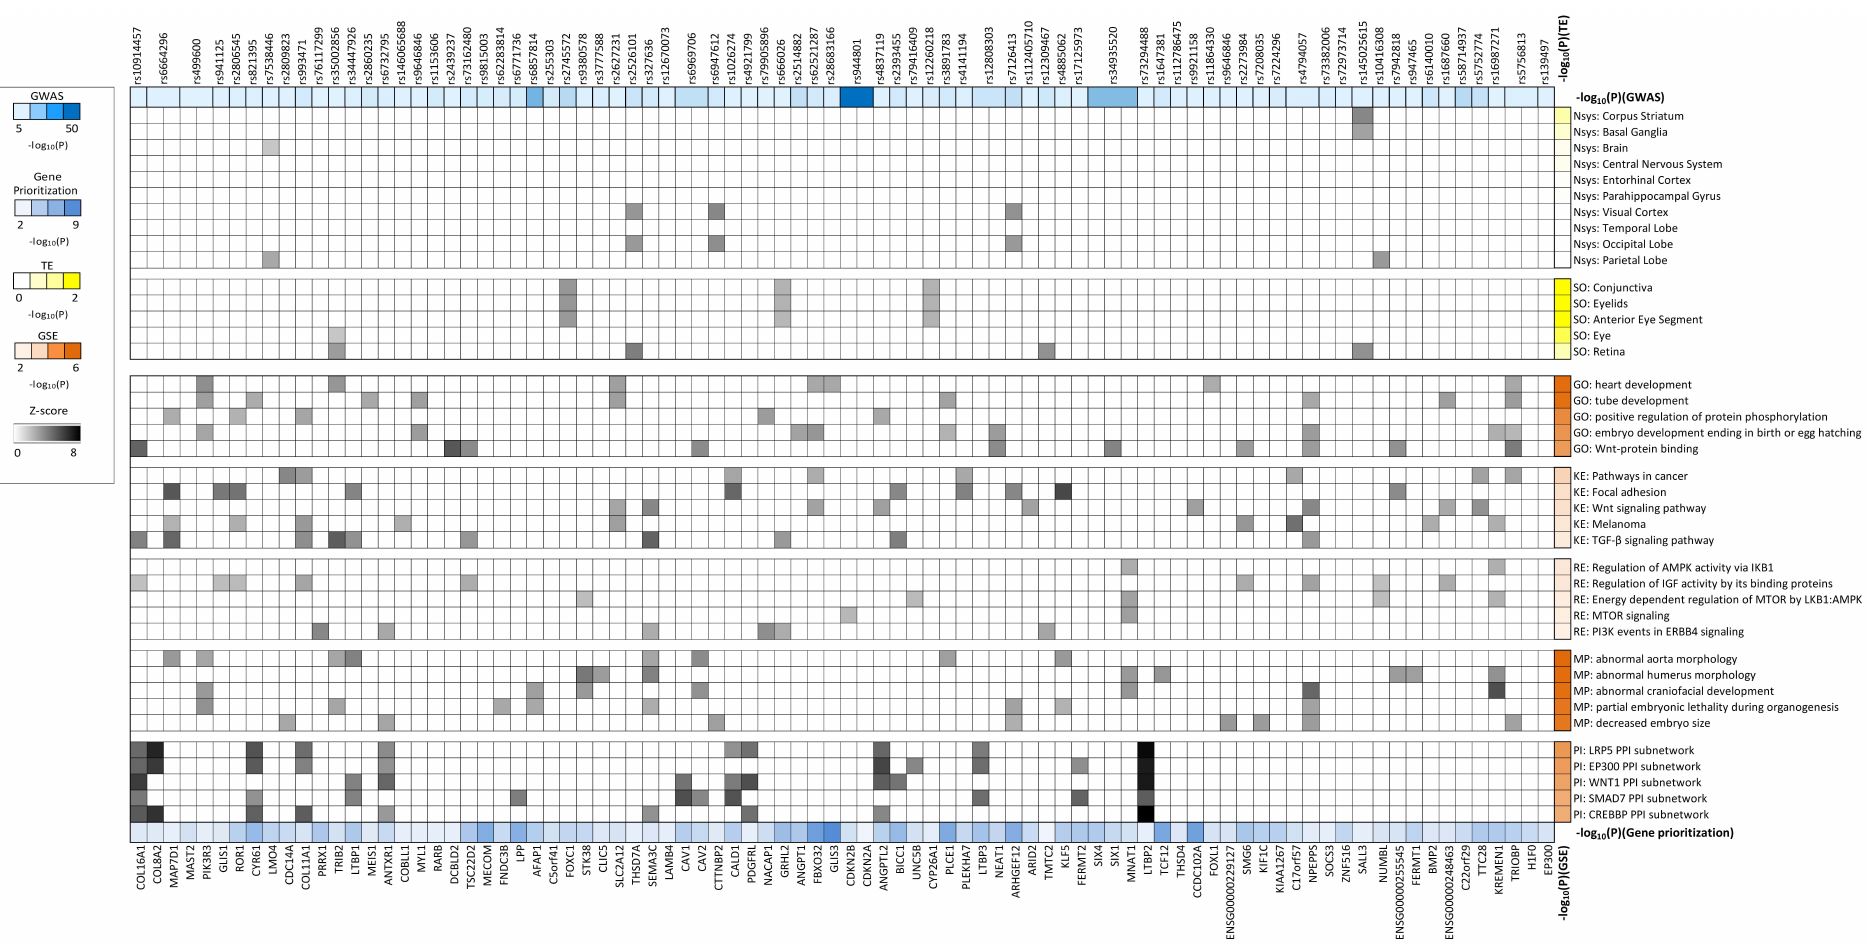
Figure 3. Heatmap of DEPICT results: DEPICT prioritized genes (FDR < 0.05) in the context of most significant DEPICT gene sets and likely relevant tissues are visualized. Gray-scale colors represent each gene’s contribution to gene-set enrichment (GSE) or tissue enrichment (TE) described as a Z-score (only the top ten Z-scores per gene set/tissue are shown). For each of the five annotation categories (GO, KE, RE, MP, PI), only the top five gene sets are visualized. Sidebars represent p -values on the logit